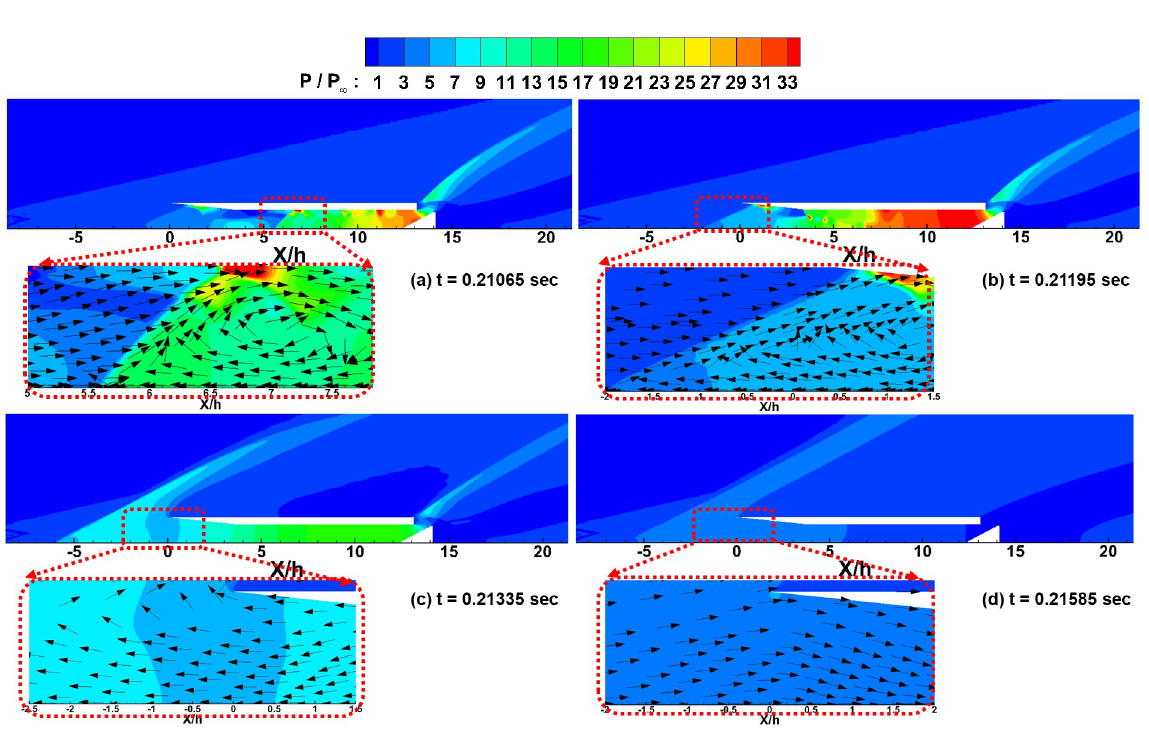
Fig 11. Normalized pressure contours for the inlet unstart case. (a) t = 0.21065 sec. (b) t = 0.21195 sec. (c) t = 0.21335 sec. (d) t = 0.21585 sec.